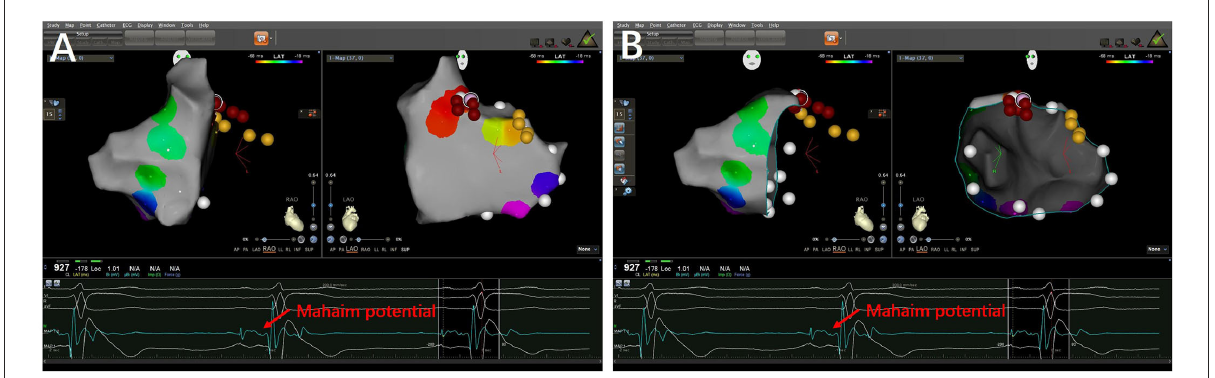
FIGURE3 3-D mapping images of successful ablation sites in a patient with right-sided MAP. (A) The targets of Mahaim fiber located at the right anterior wall of tricuspid annulus (12:00 p.m.). (B) The target in ablated catheter presented Mahaim